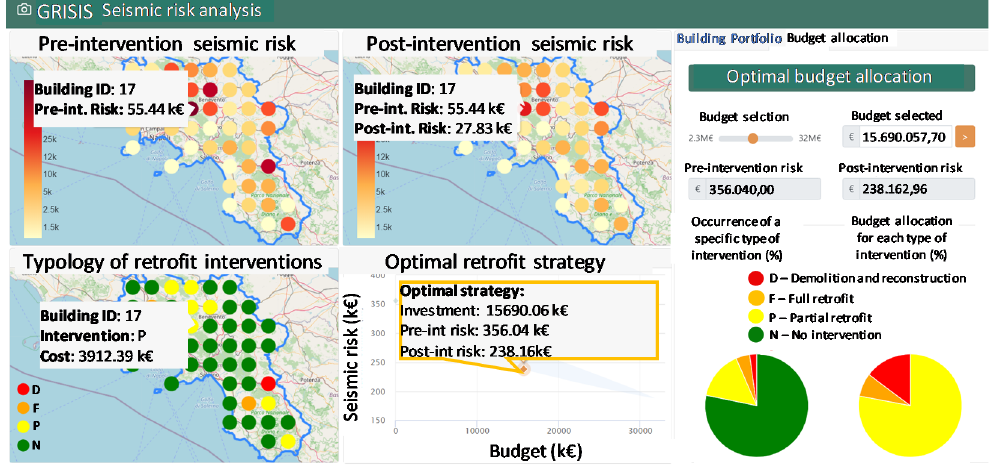
Figure 8. Interactive budget allocation and maps updating.